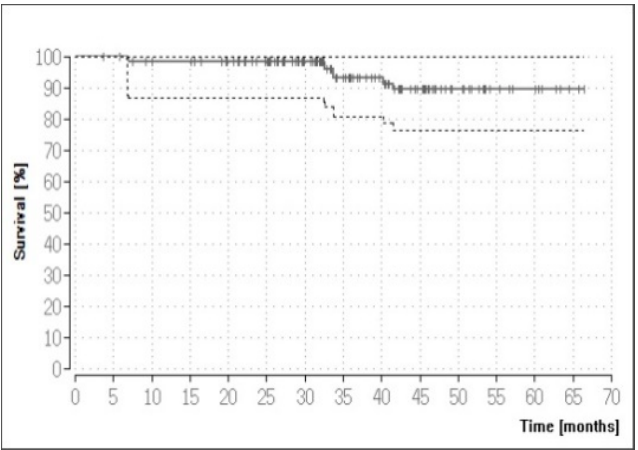
Figure 2. Kaplan–Meier survival curve for FPD restorations.